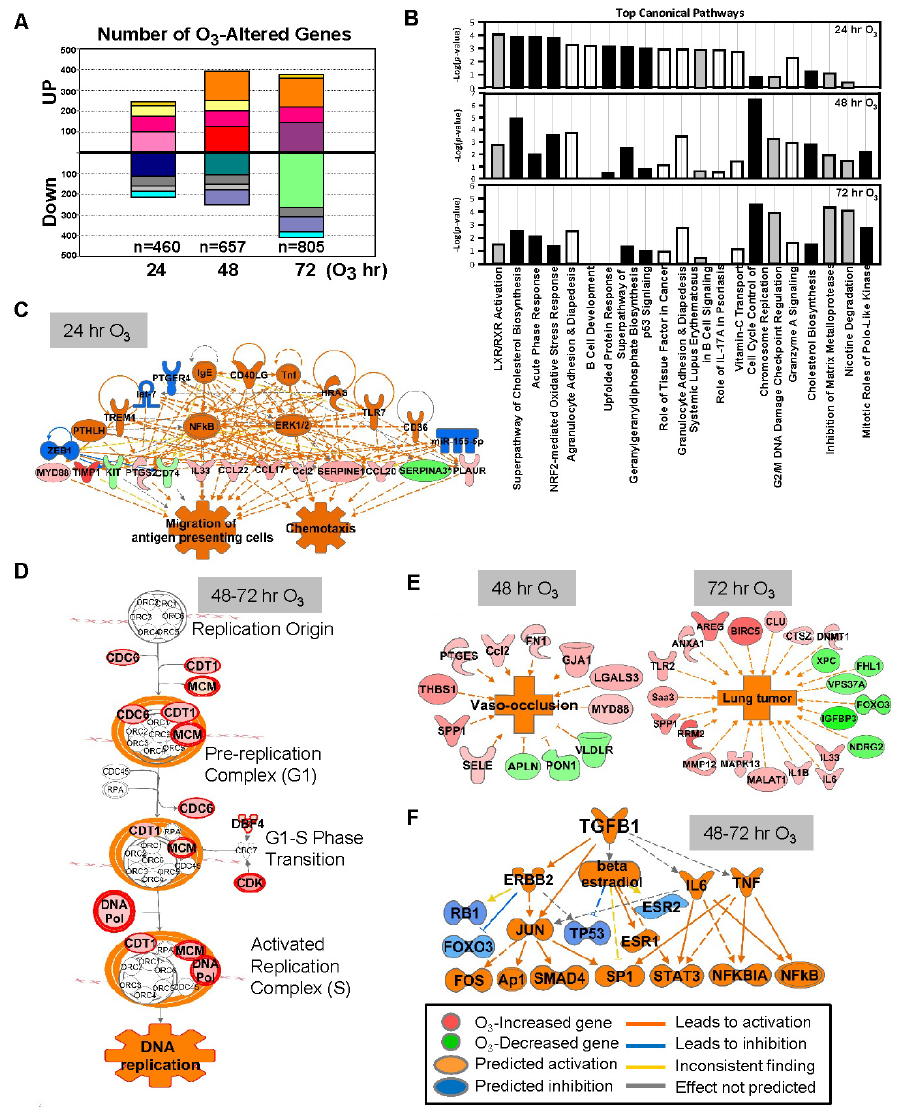
Figure 1. Effect of ozone (O 3 ) on lung transcriptomics in C57BL/6J mice. ( A ) The number of lung genes significantly increased or decreased ( p < 0.01 with moderated t-test) at 24 ( n = 460), 48 ( n = 657), and 72 ( n = 805) h of 0.3-ppm O 3 exposure relative to the air controls. Matching colors of stacks in the graph indicate overlapping genes between different times of exposure. ( B ) Top-ranked canonical pathway categories of the O 3 -altered genes at 24, 48, and 72 h are depicted against -log2( P ). Black bars = positive z-score (activation); gray bars = negative z-score (inhibition); white bars = no activity pattern available. ( C ) Pathway analysis determined that tumor necrosis factor (TNF) and nuclear factor kappa-light-chain-enhancer of activated B cells (NF- κ B) were potential key upstream regulators for the O 3 -responsive lung genes, which contribute to acute inflammatory and immune responses (e.g., migration of antigen presenting cells) at 24 h. ( D ) Cell cycle control of chromosome replication was the top canonical pathway of lung genes significantly upregulated by O 3 (in red) at 48–72 h. ( E ) Top disease and biological functions of the genes altered by O 3 included blood vessel lesion and vaso-occlusion at 48 h and lung tumor development at 72 h. ( F ) Transforming growth factor (TGF)- β 1 and P53 are predicted to be one of the key upstream regulators orchestrating the lung transcriptome changes at later times (48–72 h) of O 3 exposure. Gene or molecule colors indicate upregulation/activation (red/orange) or downregulation/inhibition (green/blue) after O 3 exposure compared with air exposure. Analyses were done using ingenuity pathway analysis and GeneSpring software.